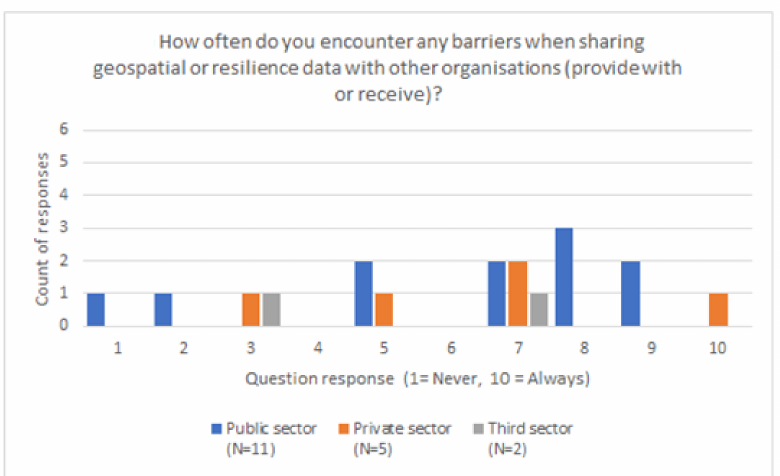
Figure 5. Number of responses per sector obtained for the following survey question: “How often do you encounter any barriers when sharing geospatial or resilience data with other organisations (provide with or receive)?”.